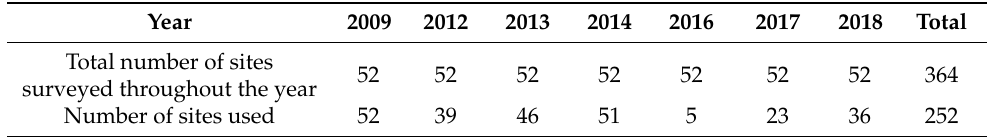
Figure 1. Spatial distribution of survey stations in the Changjiang River Estuary (Black dots represent the survey sites). Table 1. Number of sites and data volume in different years during the study.